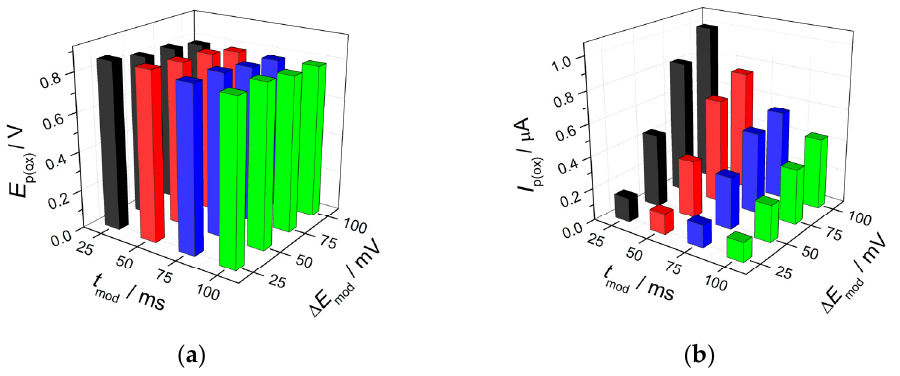
( b ) Figure 10. Baseline-corrected DPVs of isopropylmethylphenols at various concentrations at the pol- ythymolphthalein/MWCNTs/GCE in Bri tt on–Robinson bu ff er pH 2.0: ( a ) thymol; ( b ) carvacrol. Δ E- mod = 100 mV, t mod = 25 ms, υ = 20 mV s − 1 . Table 2. Calibration graph parameters of isopropylmethylphenols determination at the polythymol- phthalein/MWCNTs/GCE in Bri tt on–Robinson bu ff er pH 2.0. Analyte Linear Dynamic Range (µM)